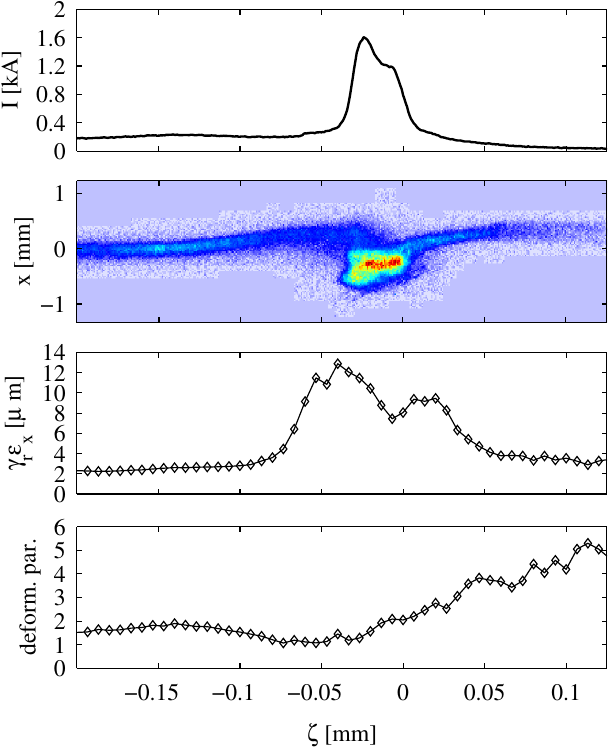
FIG. 16. (Color) Experimental results under FEL operating con- ditions at 494 MeV. From top to bottom: Average current profile, typical CCD image, normalized slice emittance, and deformation parameter. A large shear parameter S ¼ 29 has been chosen to achieve good resolution, hence only a limited section of the bunch is visible on the screen and most of the bunch tail is truncated.